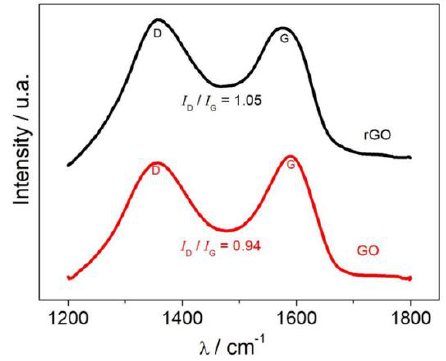
Figure 5. Spectroscopic Raman characterizations for the nanomaterials.